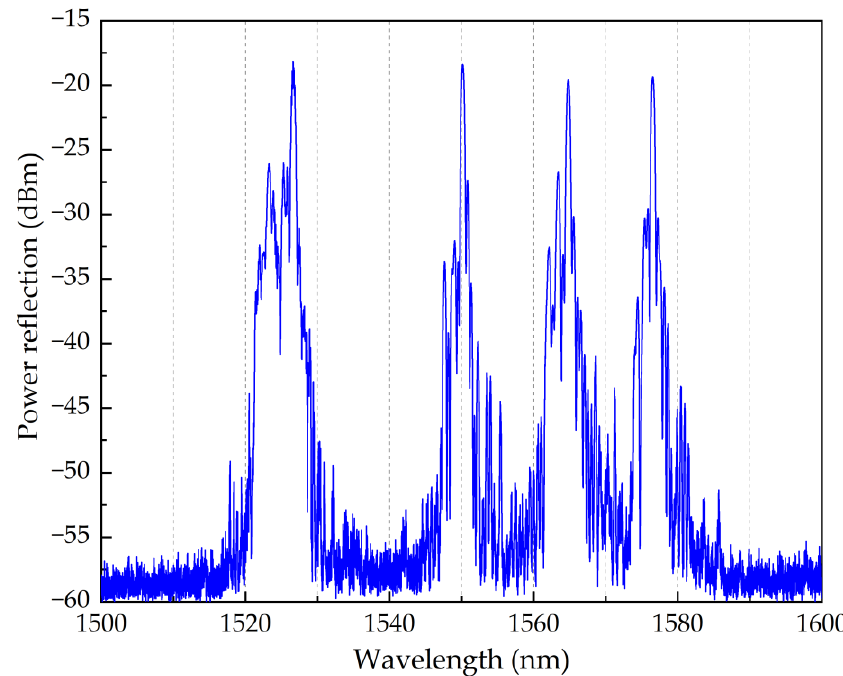
Figure 3. Reflection spectrum of array of 4 POFBG sensors.